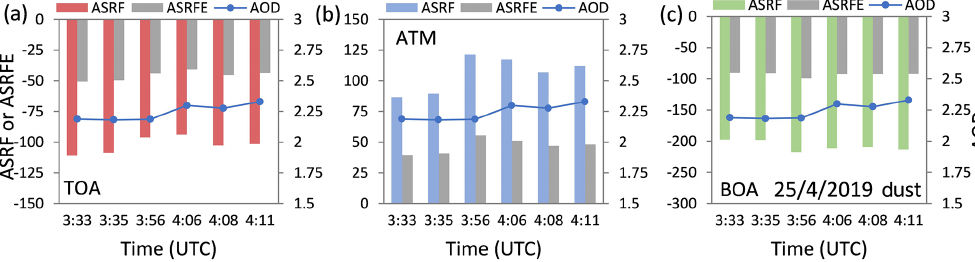
Figure 7. As Fig. 6 but for the heavy dust case on 25 April 2019.